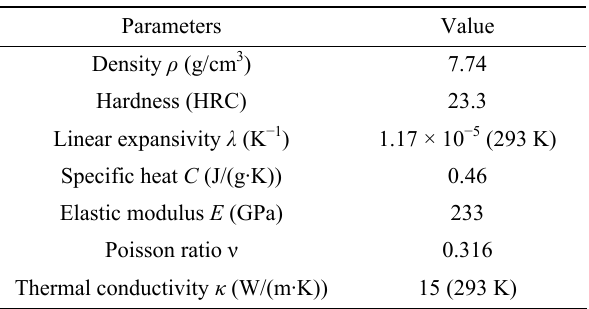
Table 2 Physics properties of the workpiece